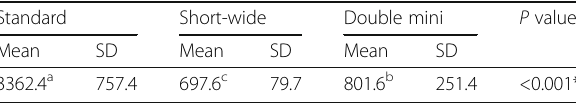
Table 1 Descriptive statistics and results of comparison between microstrains induced with different implant design regardless